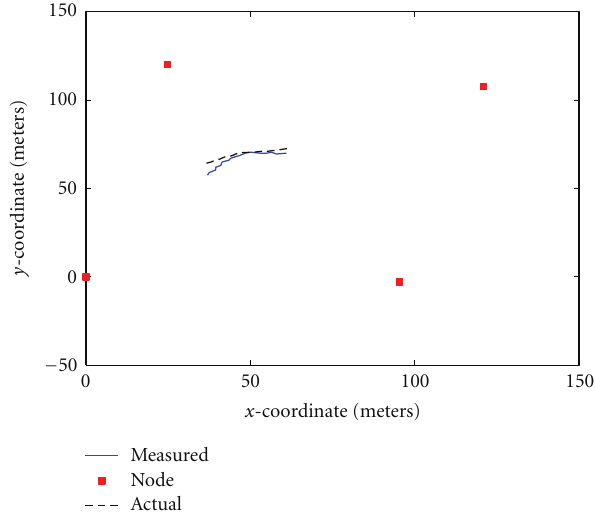
Figure 15: Plot of measurements and ground truth of lake test.